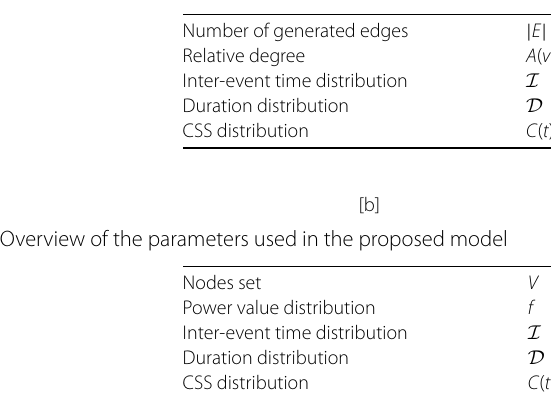
Table 1 Overview of the important characteristics of the generated networks